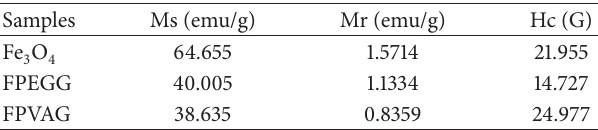
Table 1: Magnetic properties of FNPs, FPEGG, and FPVAG nano-